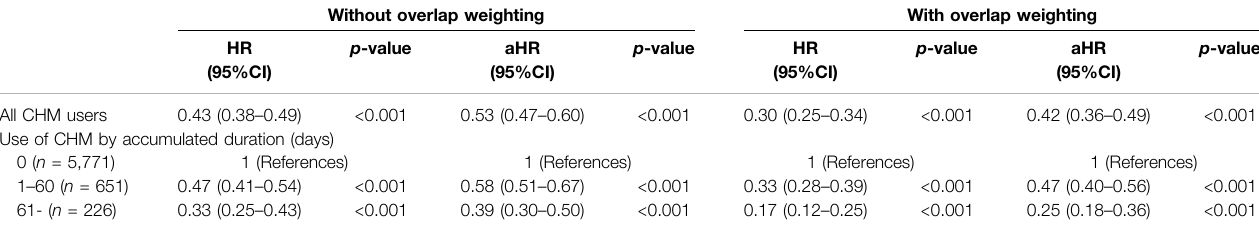
TABLE 2 | Risks of all-cause mortality among Chinese herbal medicine (CHM) users, concerning the accumulative duration of CHM. Without overlap weighting With overlap weighting